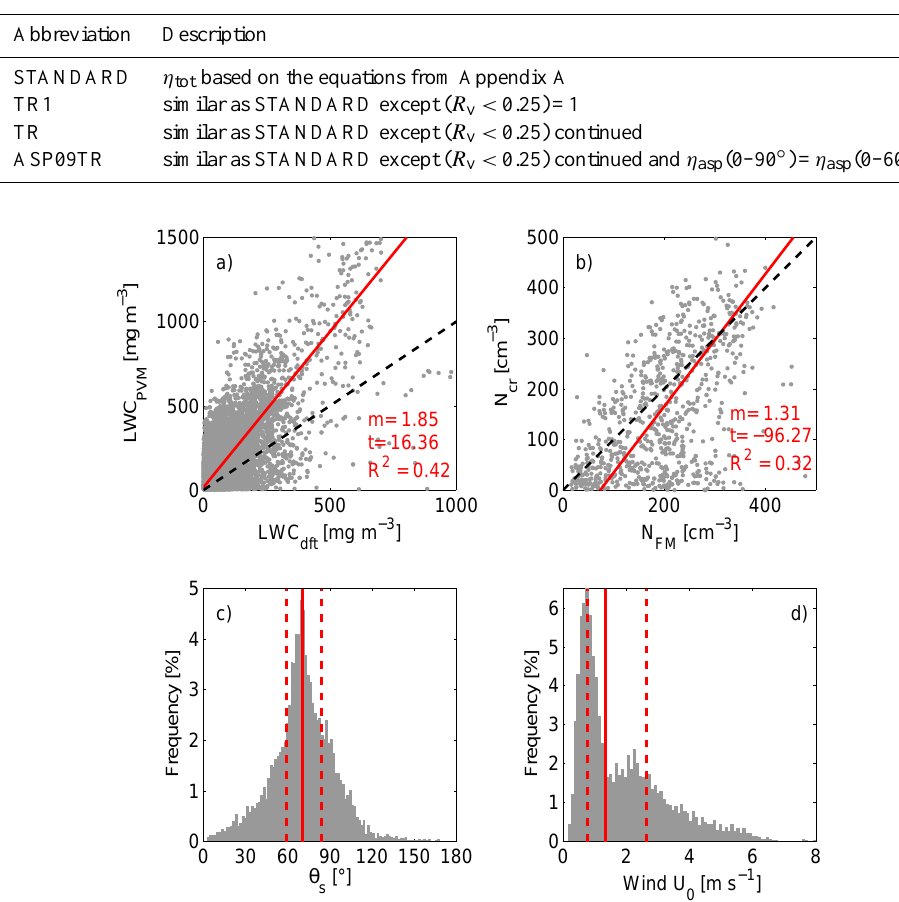
Table 3. Description of the different particle loss categories applied to the CLACE 2010 data.